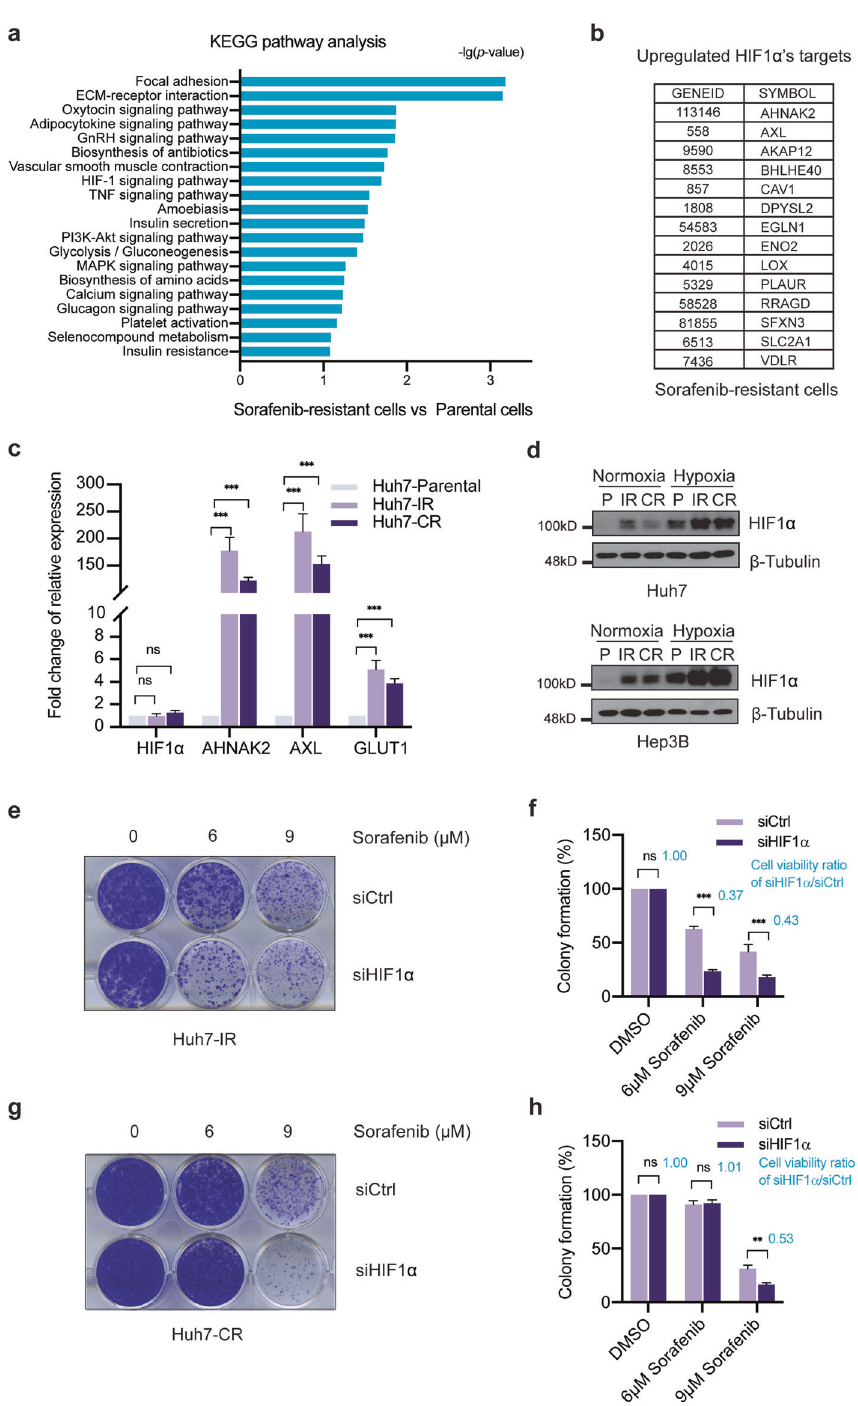
Fig. 1 Identi fi cation of HIF1 α as a biomarker of Sorafenib-resistance. a KEGG pathway analysis of the genes speci fi cally upregulated in their expression in Sorafenib-resistant cells. The HIF-1 signaling pathway was identi fi ed as an upregulated pathway. b Top list of HIF1 α target genes highly expressed in Sorafenib-resistant cells. c Huh7-IR and Huh7-CR cells expressed high mRNA levels of HIF1 α target genes HIF1 α , AHNAK2 , AXL , and GLUT1 . The transcripts of selected HIF1 α target genes were quanti fi ed by quantitative RT-PCR. Fold increases are shown ( n = 3 independent replicates). ns = not signi fi cant; * P < 0.05; ** P < 0.01; *** P < 0.001; Student ’ s t -test. d Higher HIF1 α protein levels were detected in Sorafenib-resistant Huh7-IR and Huh7-CR (upper panel) and Hep3B-IR and Hep3B-CR (lower panel) cells as compared to Huh7 and Hep3B parental (P) cells under either normoxic or hypoxic culture conditions. Immunoblotting for β -Tubulin was used as loading control. Results represent three independent replicative experiments. e – h Loss of HIF1 α in Sorafenib-resistant Huh7-IR and Huh7-CR cells induced cell death upon Sorafenib treatment. Colony formation assays were performed with Huh7-IR ( e ) and Huh7-CR ( g ) cells transfected with either siCtrl or siHIF1 α and treated with different concentrations of Sorafenib (0 μ M, 6 μ M, 9 μ M) for 2 weeks. Colony formation was quanti fi ed by crystal violet staining ( f , h ). The ratio of cell viability between HIF1 α -de fi cient and HIF1 α -wildtype cells is given in blue numbers ( f , h ). n = 3 independent replicates. ns not signi fi cant; ** P < 0.01; *** P < 0.001; Student ’ s t